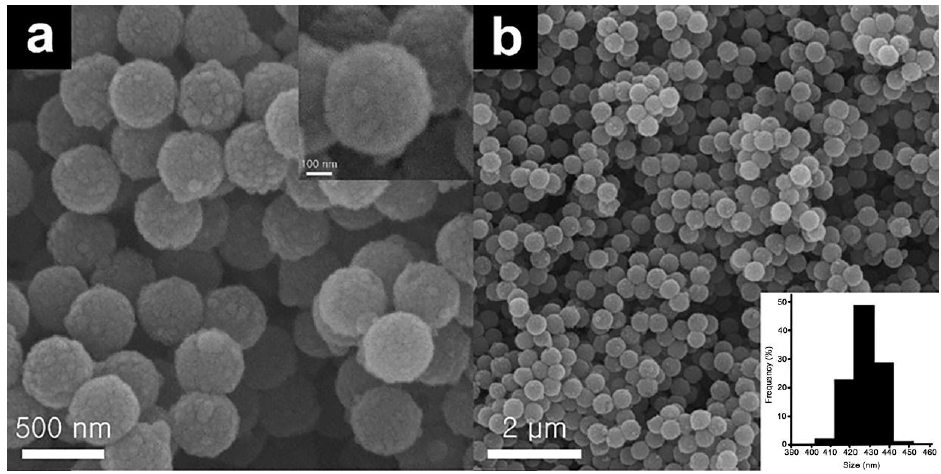
Figure 4. SEM images of Pd/PS@ZIF-8@mSiO 2 nanocomposites ( a , b ). The insert in ( a ) is high-resolution SEM image and the insert in ( b ) is the size distribution of Pd/PS@ZIF-8@mSiO 2 nanocomposites.